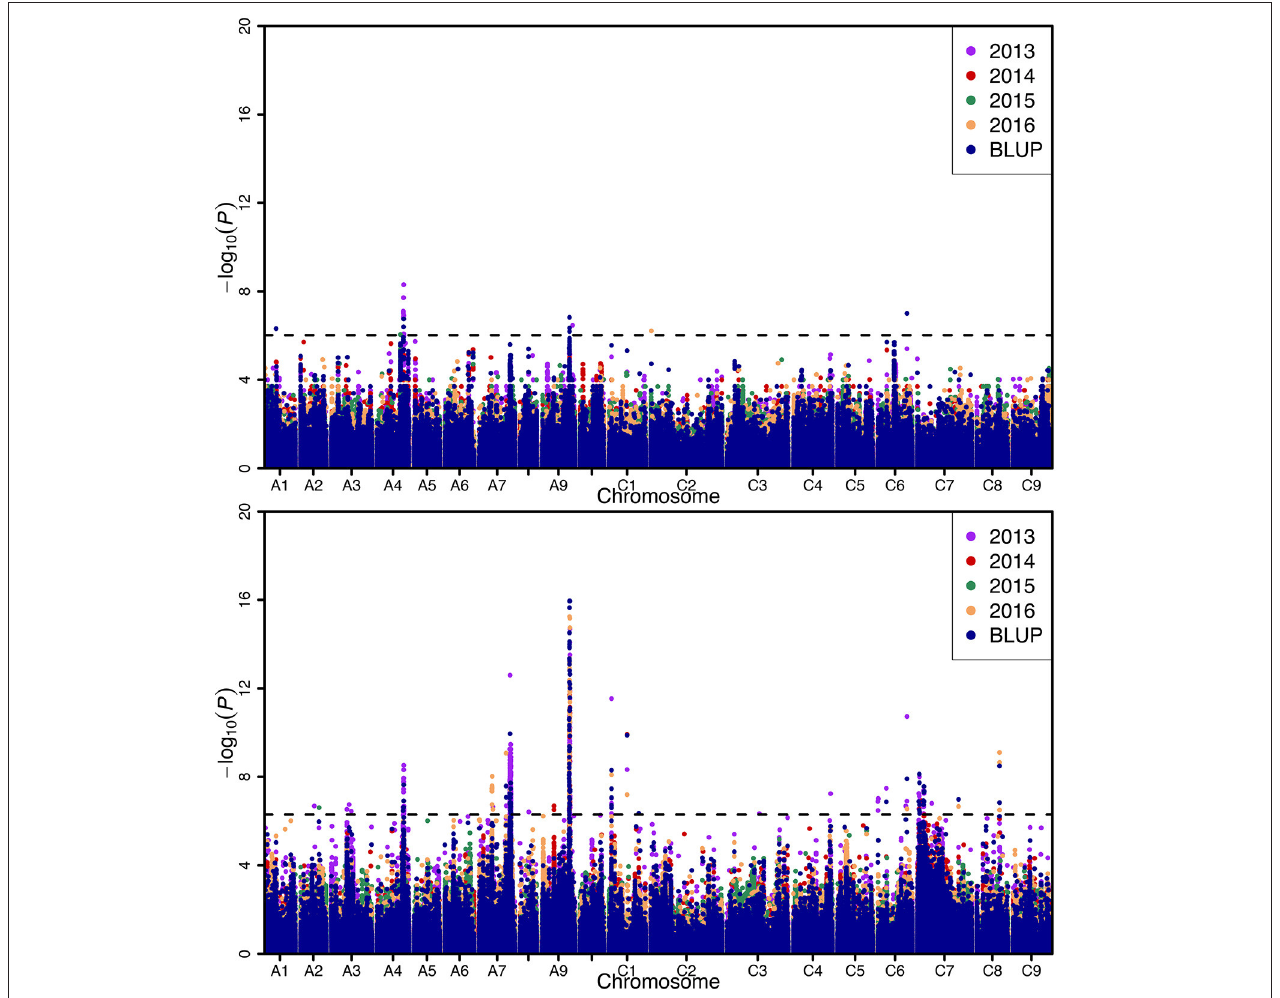
FIGURE 3 | Manhattan plots of the genome-wide association mapping for seed weight (up) and silique length (below). X-axis indicates the physical positions of single nucleotide polymorphism (SNP) along the 19 chromosomes; each environment is displayed by different colors, while y-axis is the value of -log 10 (P). The horizontal dashed line represents the significance threshold with -log 10 (P) =